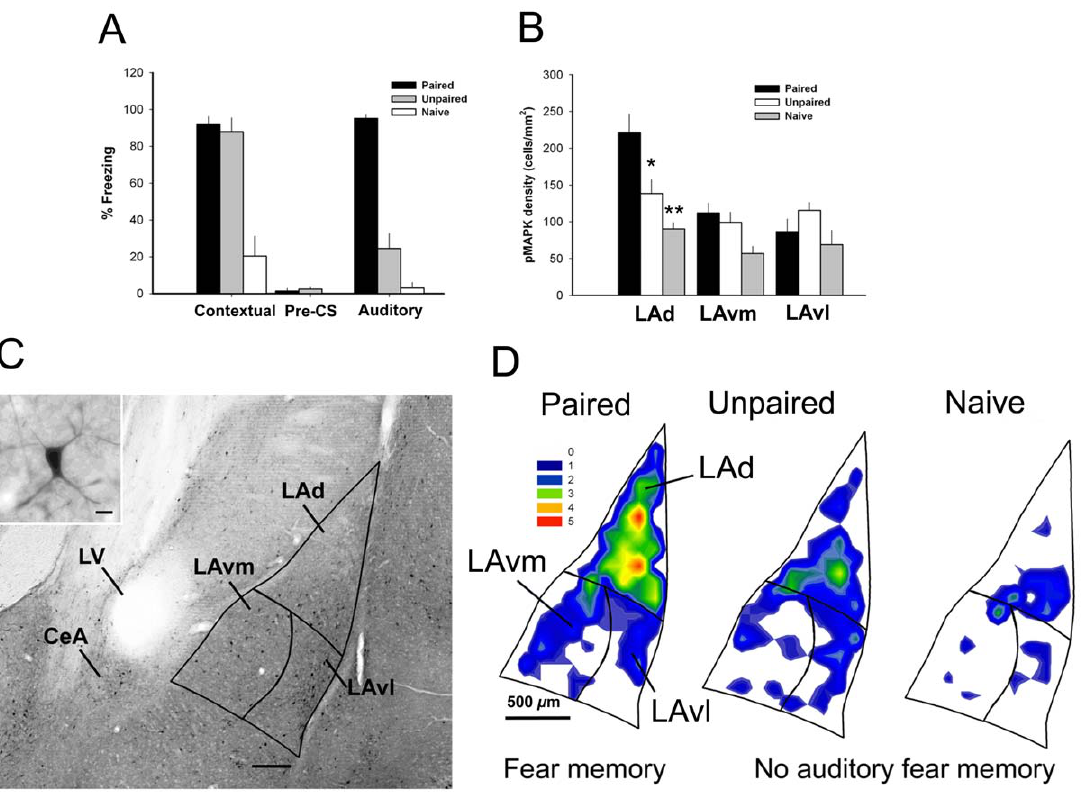
Figure 2. Auditory fear conditioning was accompanied by greater density of pMAPK expressing neurons in the LAd. (A) Paired presentation of the tone and shock produced greater freezing levels when the auditory CS was presented alone in a novel environment relative to the explicitly Unpaired and Naı¨ve control conditions (one-way ANOVA; Bonferroni post-hoc). Freezing prior to the presentation of the auditory CS in a novel chamber (pre-CS) was low for all conditions (B) pMAPK neuron density was increased in the P5 relative to both control conditions for the LaD (Multivariate ANOVA with Bonferroni post-hoc). (C) Photomicrograph of a pMAPK labeled section of LA subnuclei (4X magnification; scale bar =100 m m) and representative pMAPK labeled neuron from the LAd (40X magnification; scale bar =10 m m). (D) Micro density heat maps of the LAd, LAvm and LAvl sub regions of the LA depicting the distribution of pMAPK labeled cells in the Paired, Unpaired and Naı¨ve conditions. The colors for each bin reflect an estimation of spatial density from low (blue) to high (red).* denotes p , .05, ** p , .01, *** p , .001.